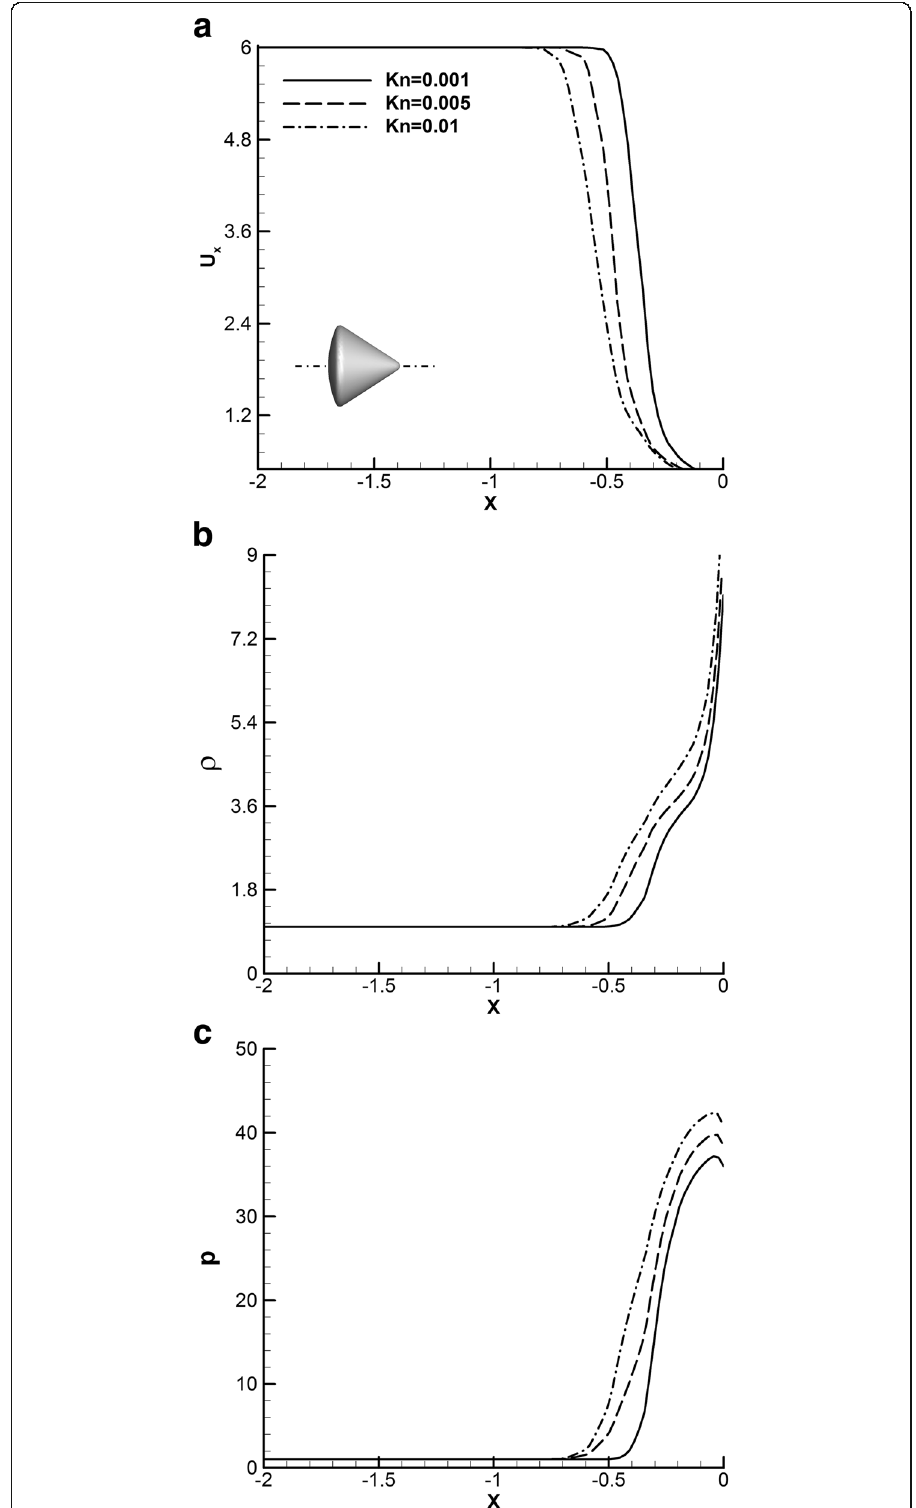
Fig. 20 Comparison of profiles of normalized conserved variables for different Knudsen numbers (0.001, 0.005, and 0.01) measured along the central axis line y = 0 at M = 6: a U x velocity, b density, and c